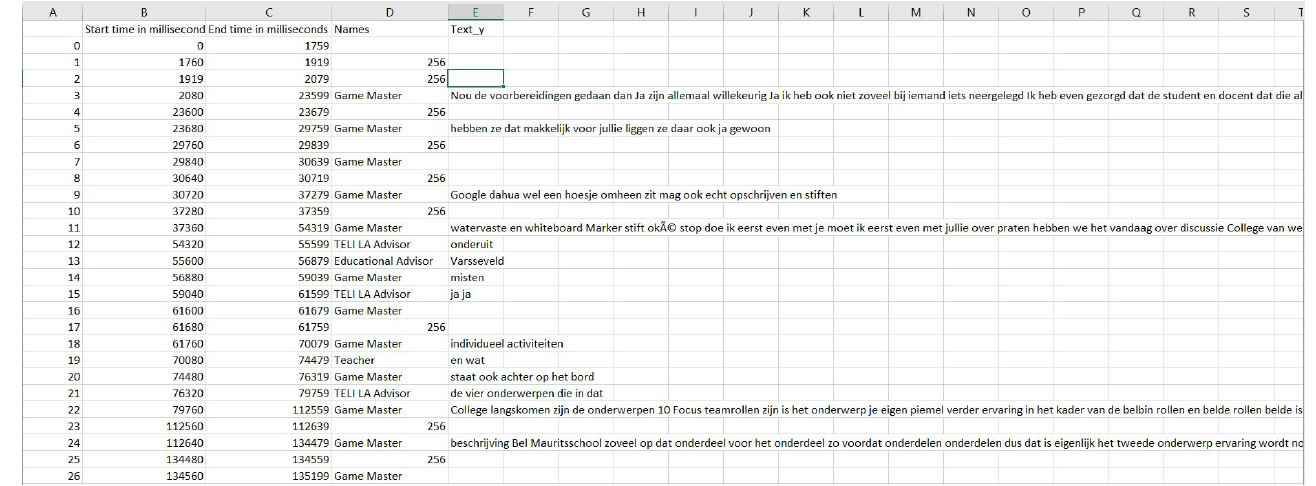
Figure 3. A sample from the data table in .csv